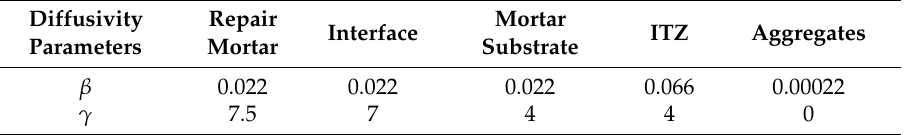
Table 1. Diffusivity parameters used in the lattice moisture transport model to obtain diffusion coefficient, D ( mm 2 /day) (Equation (2)). Parameters are adjusted such that the moisture profiles in the repair system at 1 day, 10 days and 110 days are the same as those obtained by Wittmann and Martinola [12].